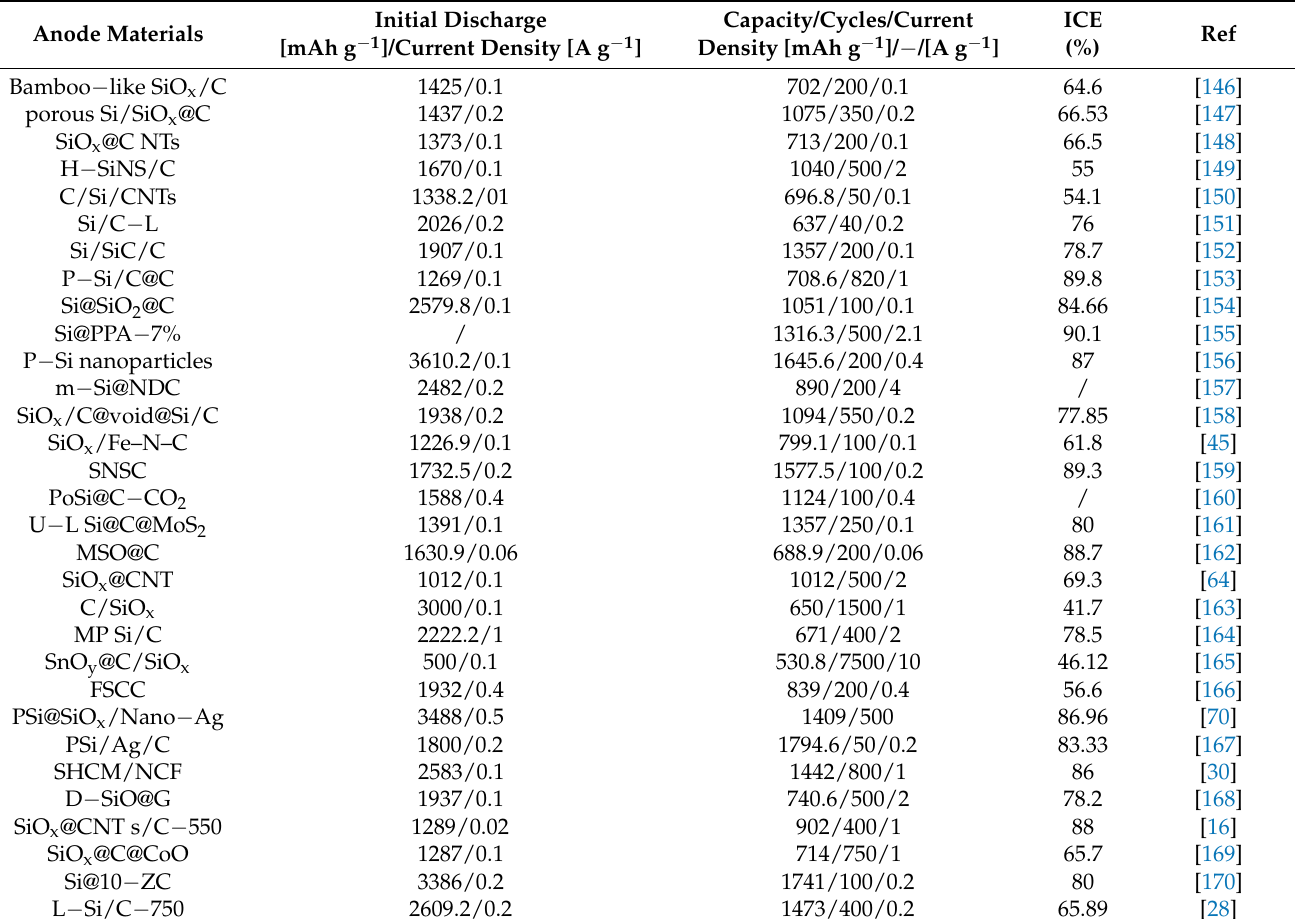
Table 1. List of typical properties in recent